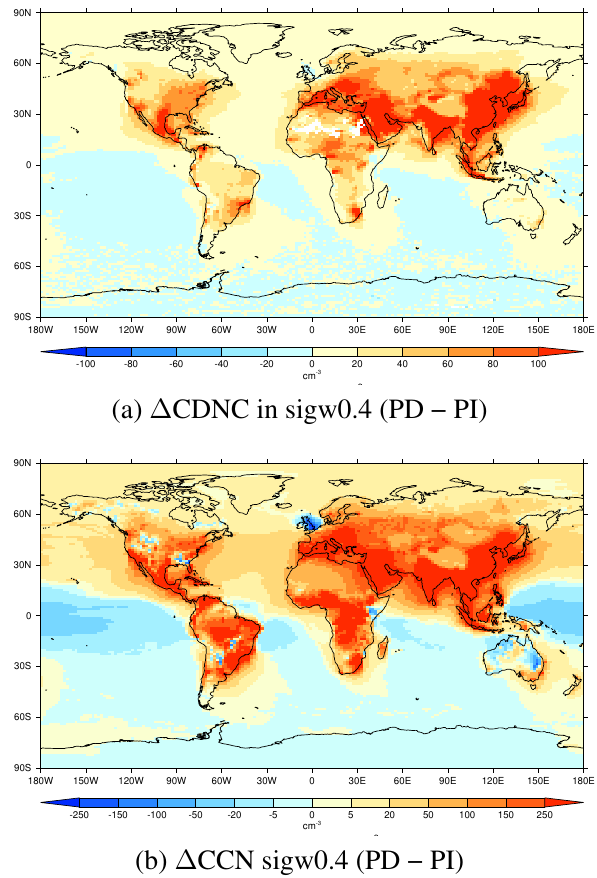
Figure 11. Change in annual mean (a) CDNC at 720m (AWM = Fig. 11 : Change in annual mean (a) CDNC at 720m (AWM = 23 . 8cm − 3 ) and (b) CCN at 23 . 8cm − 3 ) and (b) CCN at S = 1% (AWM = 81 . 6cm − 3 ), in S = 1% (AWM = 81 . 6cm − 3 ), in model sigw0.4. Maps show absolute difference between a pair model sigw0.4. Maps show absolute difference between a pair of of simulations with pre-industrial and present day aerosol emissions (PD − PI). Note non-linear simulations with pre-industrial and present-day aerosol emissions (PD − PI). Note non-linear colour bar in (b) colour bar in (b). 58